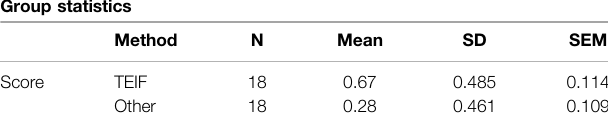
TABLE 12 | Average rankings of the two groups.